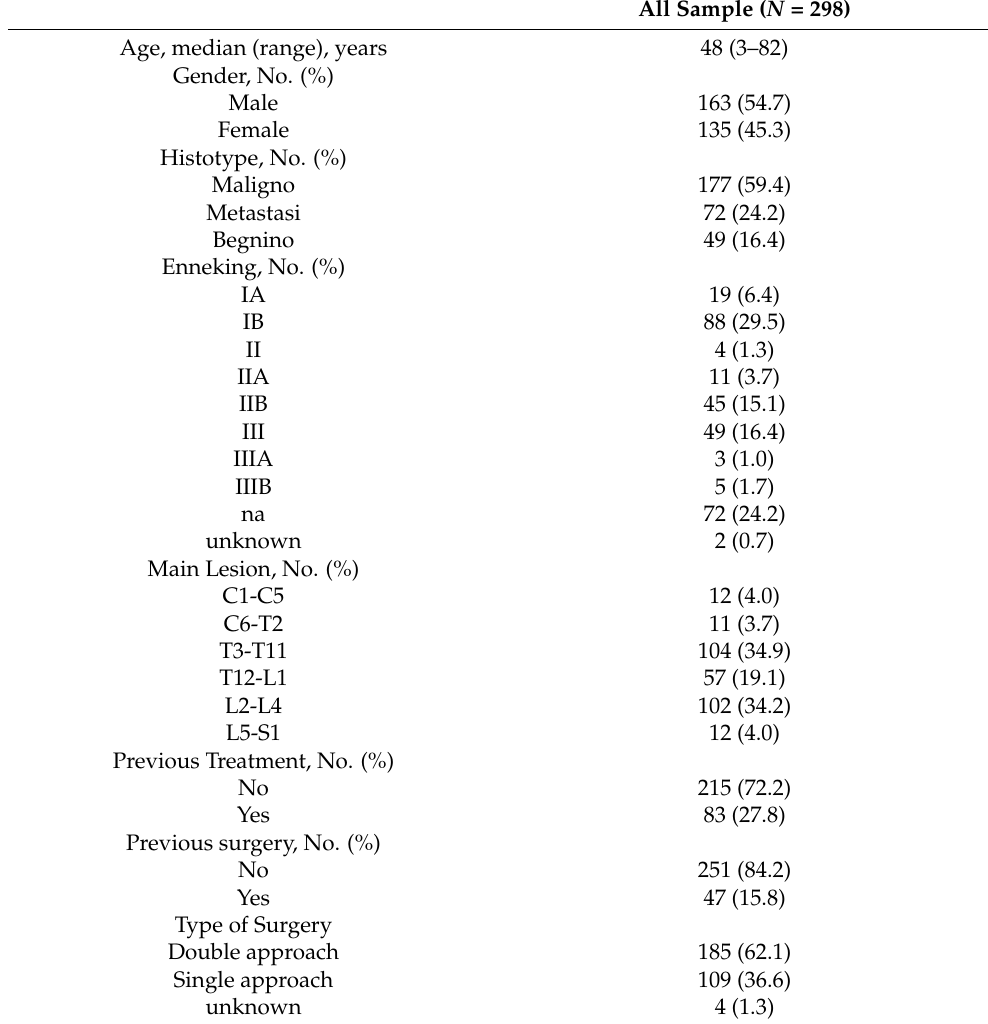
Table 2. Patients’ characteristics.